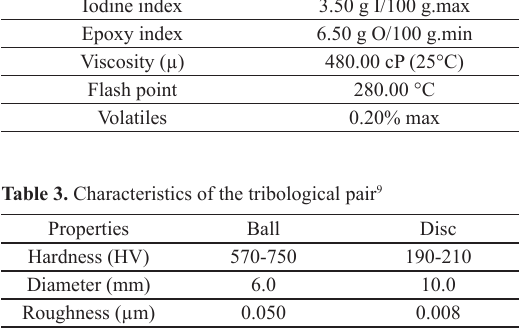
Table 5. Composition of the microemulsions